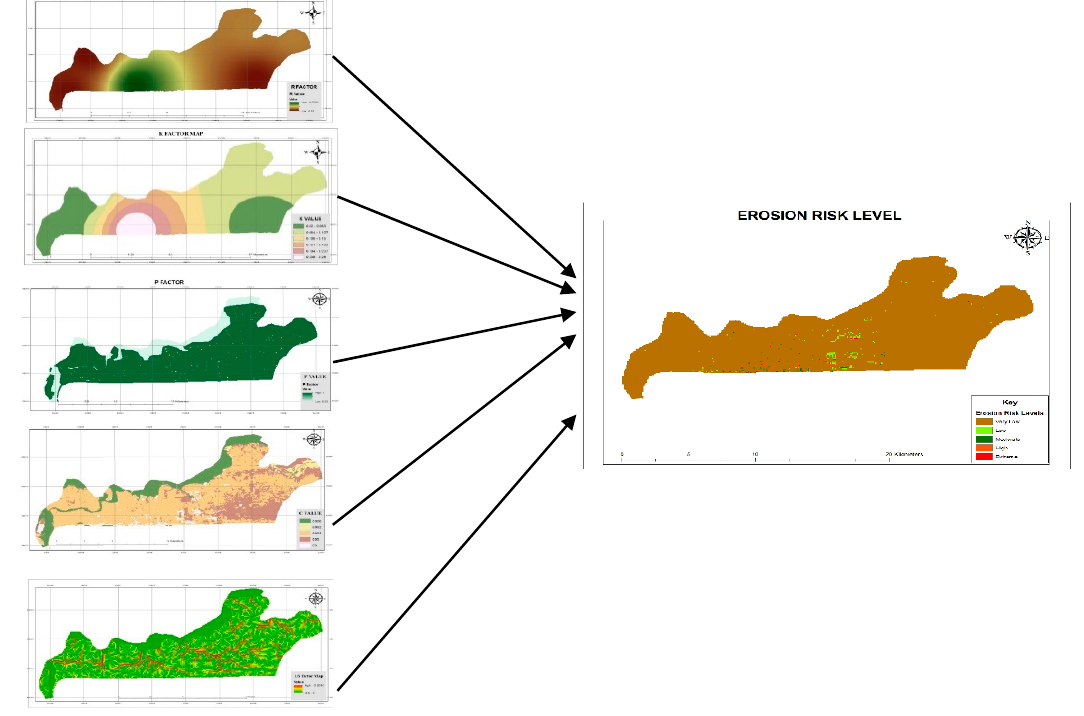
Figure 3. The data layers (maps) obtained for K, LS, R, C, and P factors of the RUSLE model and integrated to produce the Erosion Risk Level